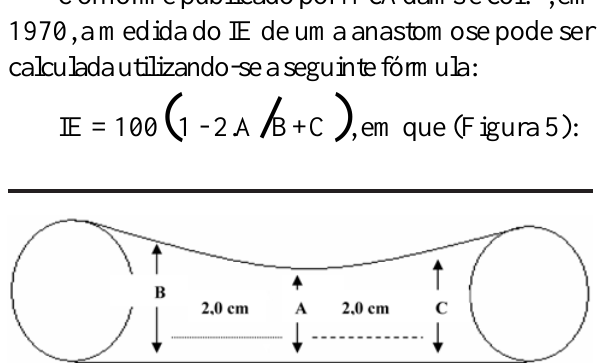
FIGURA 5: Representação esquemática mostrando os locais onde foram obtidas as